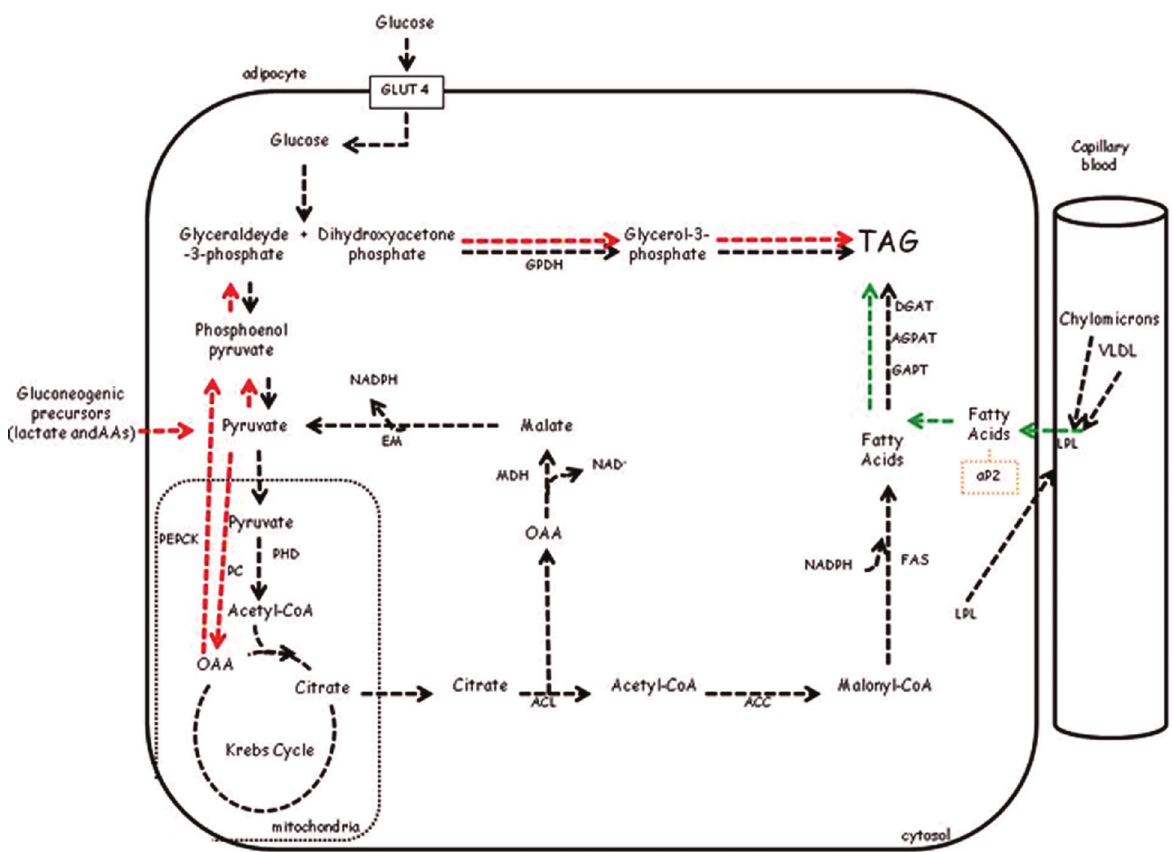
Figure 1. Lipogenic pathways. Black arrows: lipogenesis from glucose; red arrows: glyceroneogenesis; green arrows: TAG synthesis from circulating fatty acids. ACC: acetyl-CoA carboxylase; ACL: ATP-citrate lyase; AGPAT: 1-acylglycerol-3-phosphate acyltransfer- ase; aP2: fatty acid binding protein; DGAT: diacylglycerol acyltransferase; ME: malic enzyme; FAS: fatty acid synthase; GPAT: glycerol-3-phosphate acyltransferase; GPDH: glycerol phosphate dehydrogenase; LPL: lipoprotein lipase; MDH: malate dehydrogen- ase; OAA: oxaloacetate; PC: piruvate carboxylase; PDH; piruvate dehydrogenase; PEPCK: phosphoenolpyruvate carboxykinase; VLDL: very low-density